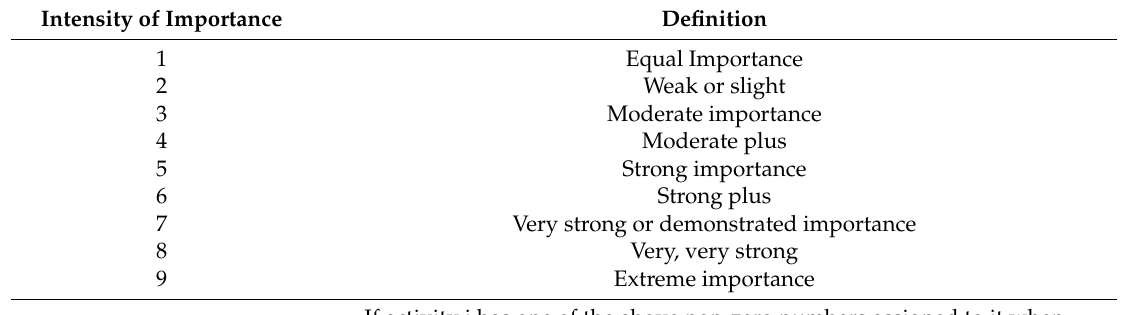
Table 2. Scales for pair-wise AHP comparisons [45].